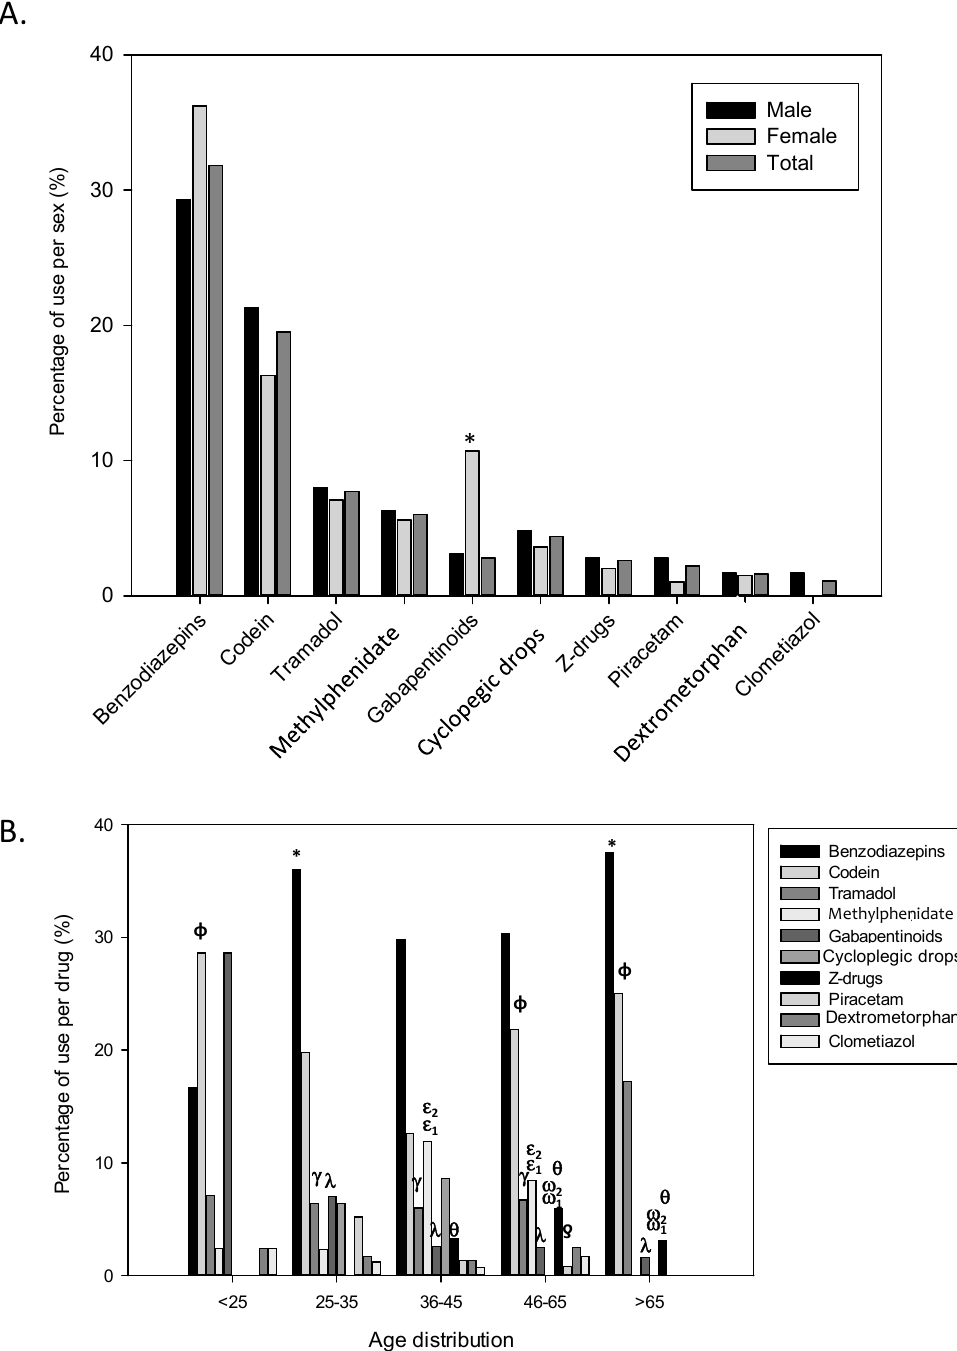
Figure 2. Proportion of the type of drug. Distribution of the participants according to ( A ) type of drug and sex and, ( B ) type of drug and age. The proportions are calculated from each condition related to 548 notifications analysed. As it can be observed the drug abuse was also differentially distributed by age and different patterns were obtained for specific drugs and ages. Statistical differences: ( A ) * p < 0.05 vs. men and ( B ) * p < 0,05 vs. range < 25 in benzodiazepins group, F p < 0.05 vs. range 36–45 in codein grup, γ p < 0.05 vs. range > 65 in tramadol group, ε 1 p < 0.05 vs. range 25– 35; ε 2 p < 0.05 vs. range > 65 in methylphenidate group, λ p < 0.05 vs. range < 25 in gaba group, ω 1 p < 0.05 vs. range 25–35; ω 2 p < 0.05 vs. range 36–45 in cicloplegic, θ p < 0,05 vs. range 25–35 in z-drug group, ƍ p < 0.05 vs. range 25–35 in piracetam